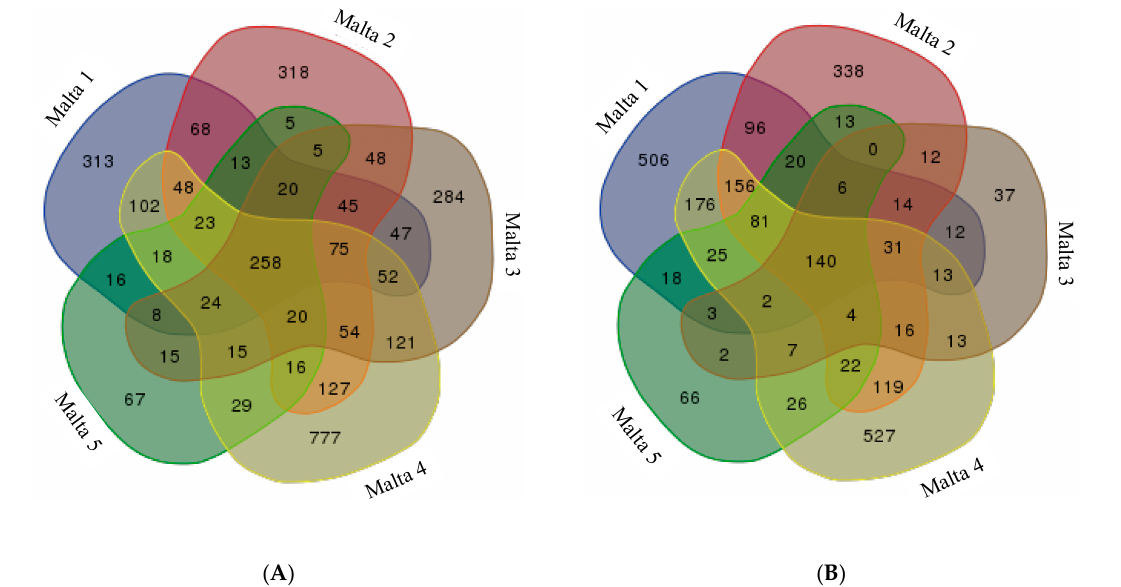
Figure 1. Comparison among the five white poplar samples of the contigs obtained from ( A ) Eco RI- Msp I digestion (3031); ( B ) from Eco RI- Hpa II digestion (2501).